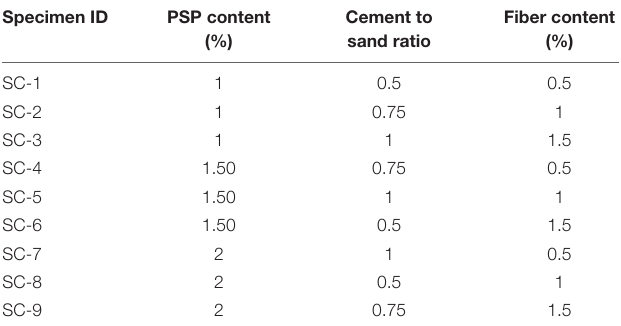
TABLE 4 | Summary of the mix design